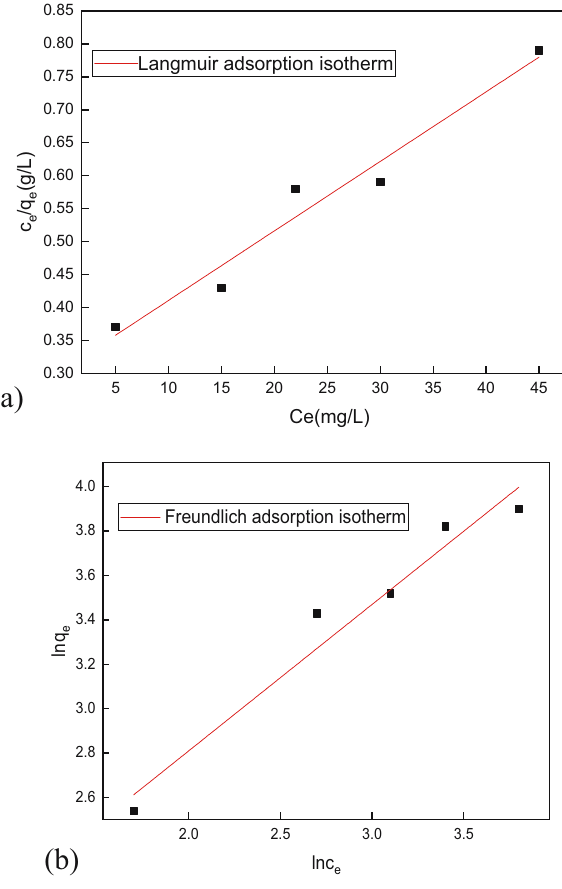
Figure 7: E ff ect of initial concentration of lead ion solution on the adsorption performance of GC adsorbent.